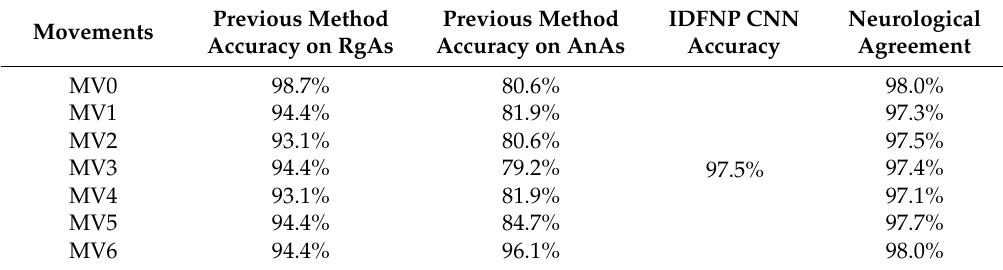
Table 7. Comparison with previous method and neurological agreement.